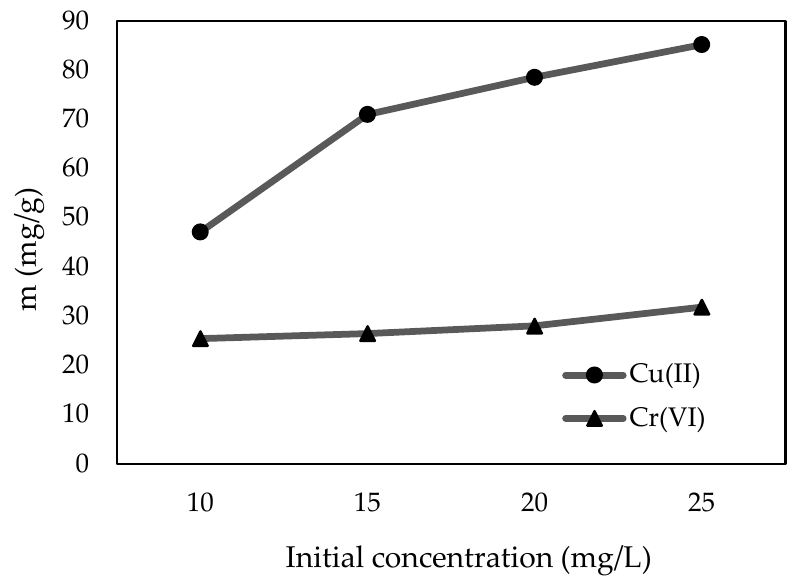
Figure 4. Effect of initial concentration on metal ions adsorption. (C-ZLCH: 0.01 g, volume (mL): 50, pH: 8.1 for Cu(II), pH: 6.7 for Cr(VI), temperature: 30 °C, and time: 30 min).